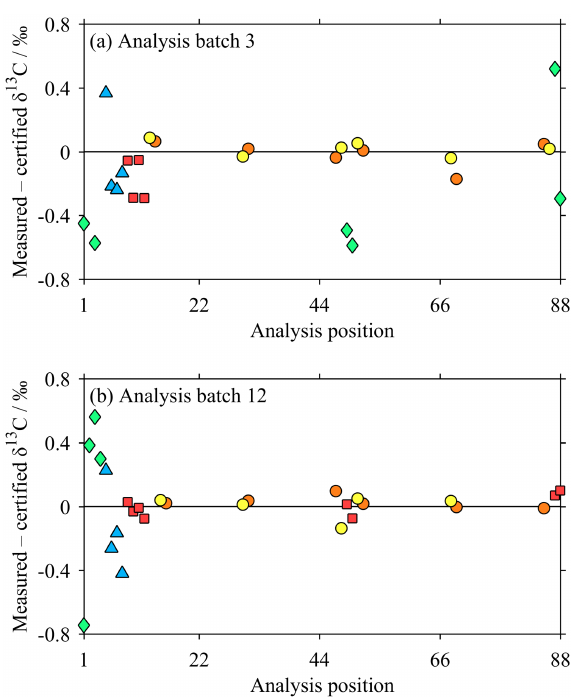
Figure 11. Examples of results of standards and RM within batches (a) 3 and (b) 12. Red squares for MAB, green diamonds for NA, blue triangles for CA, orange circles for RM141, and yellow circles for